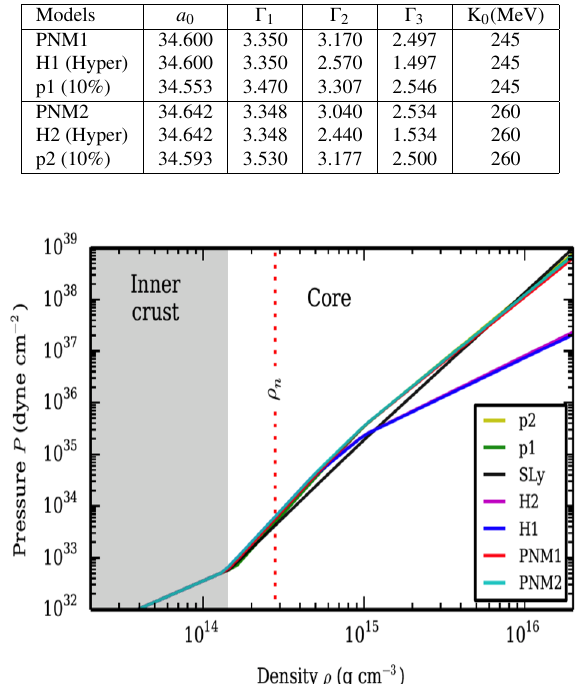
Figure 2: (Color online). The pressure as function of nu- clear density for all the model parameters as they defined in the Table 2, based on assumption that nuclear force is being mediated by a 17 MeV